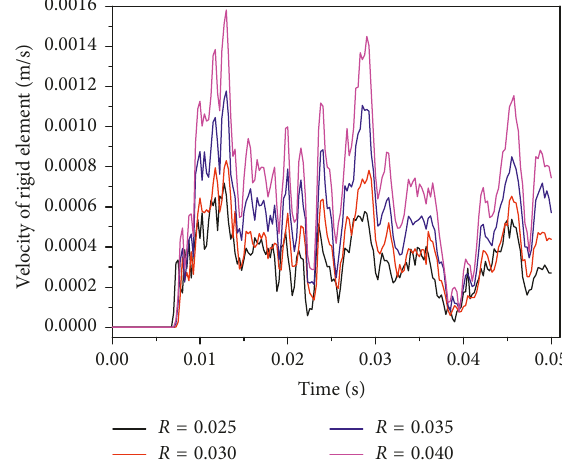
Figure 30: Spring stress.